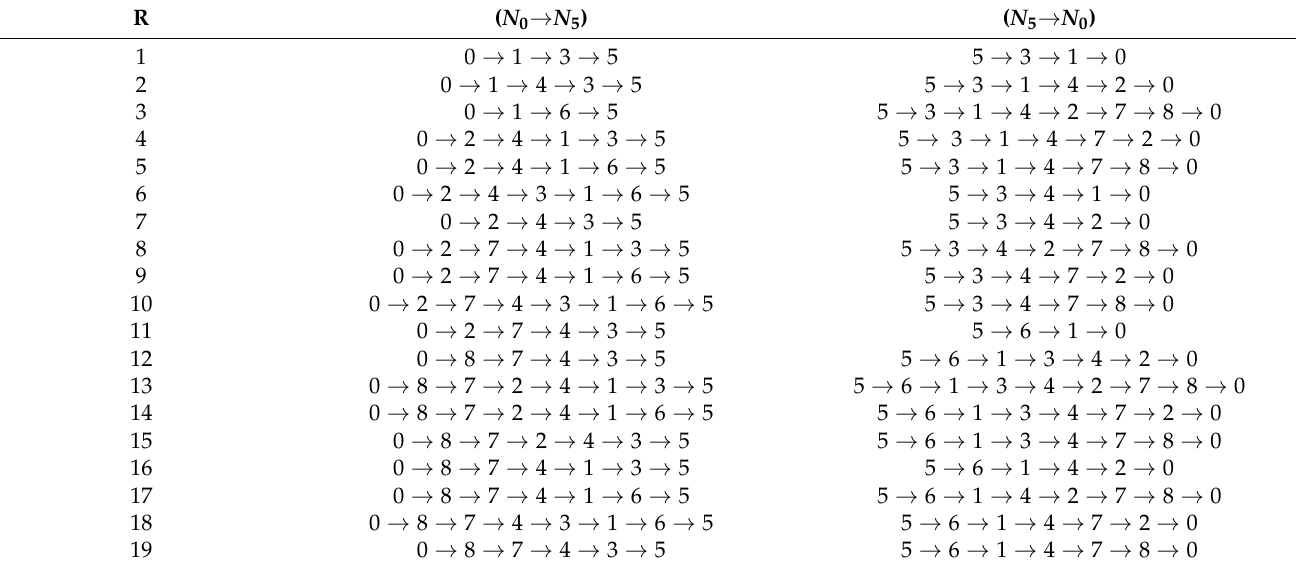
Table 2. The computed routes from the starting node N 0 to the target node N 5 and from the target node N 5 to the starting node N 0 .